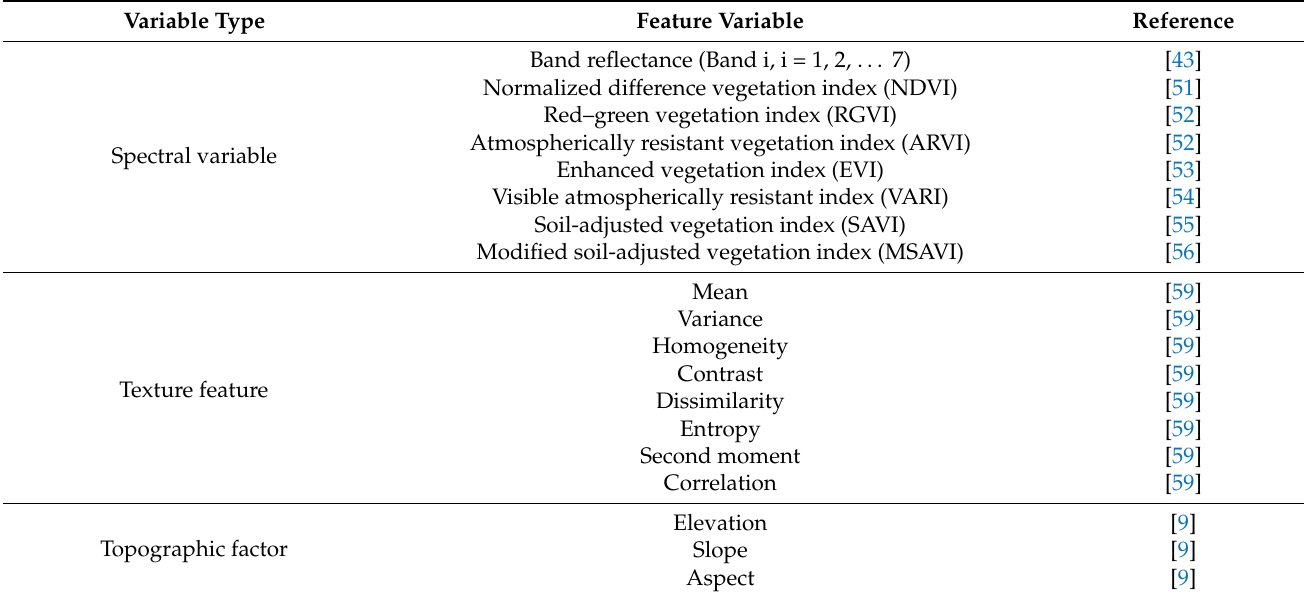
Table 3. List of feature variables used in this